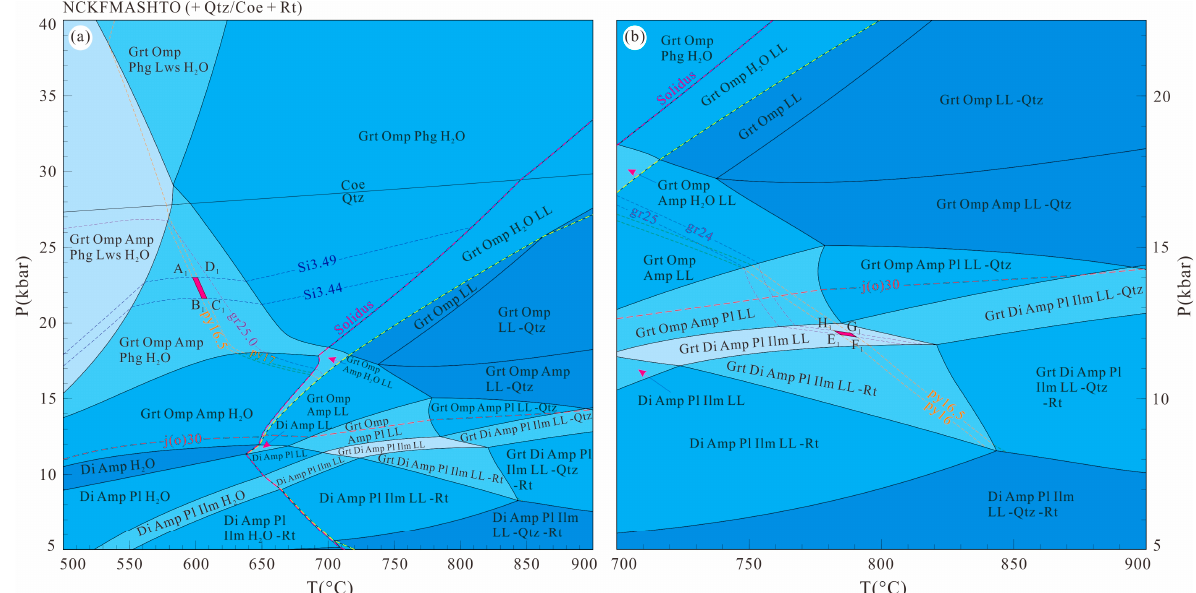
Figure 9a, P-T (supra-solidus fields) Figure S2a, P-X(CaO) Figure S2b, T-X(MgO)